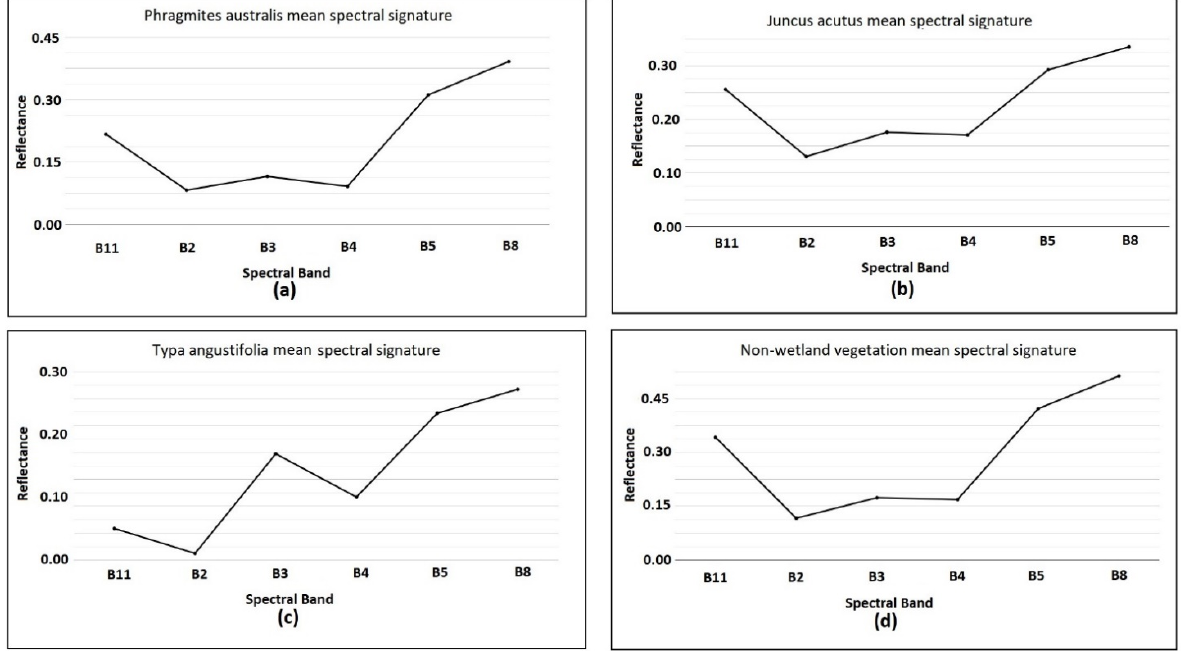
Figure A5. Growing season mosaic of the target year of 2021 ( a ) and wetland map of target year of 2021 using migrated samples ( b ).